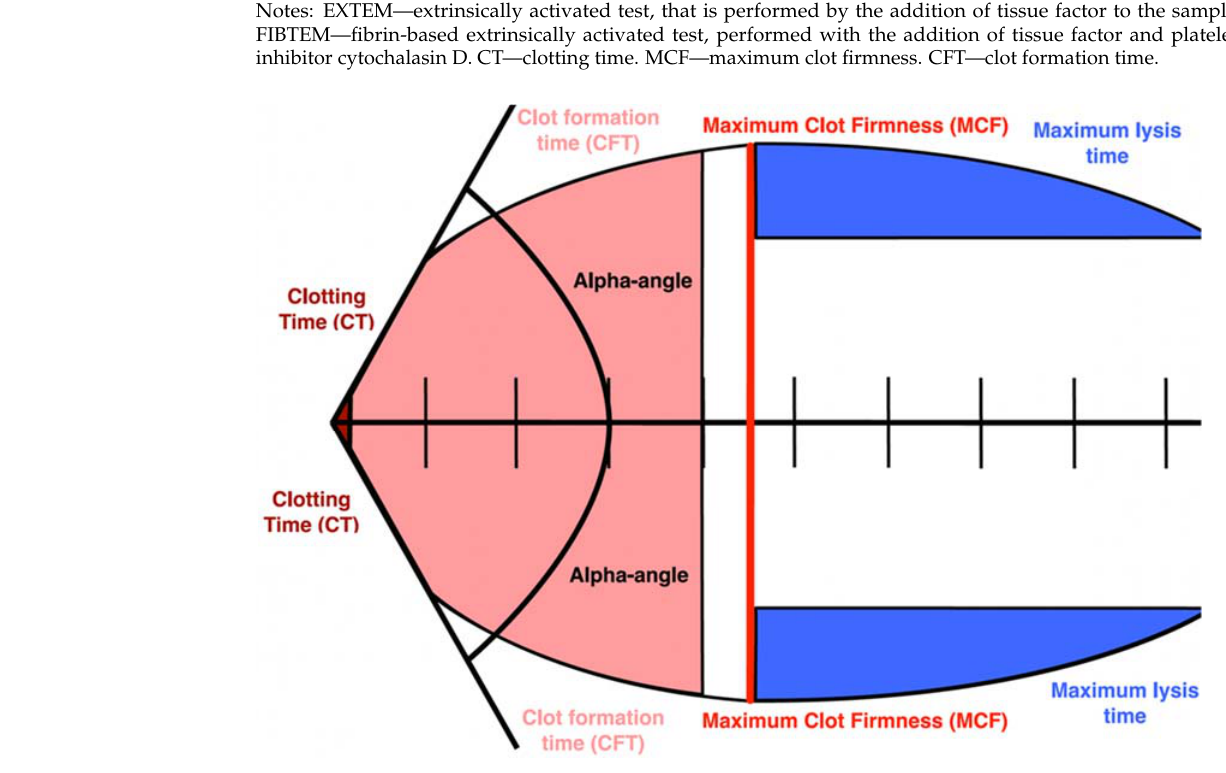
Figure 2. ROTEM parameters in COVID-19 Laboratory parameters and their association with the most frequent pathways in CAC are presented in Table 3. Table 3. Laboratory findings associated with thrombosis in intensive care unit COVID-19 patients [34,45,59].